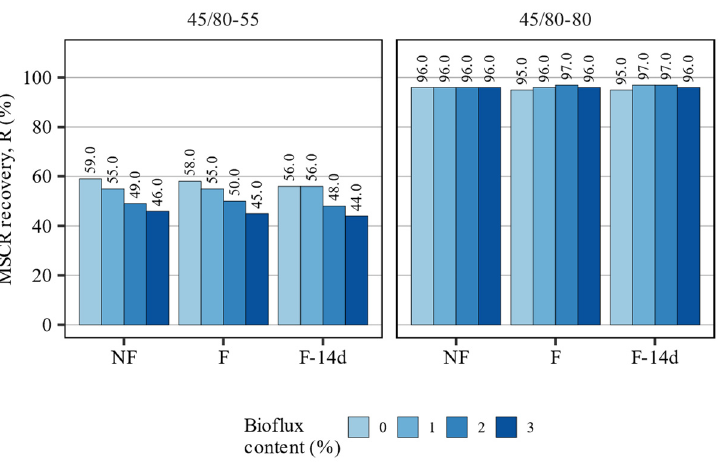
Figure 9. MSCR recovery R at 3.2 kPa stress level and 60 °C.